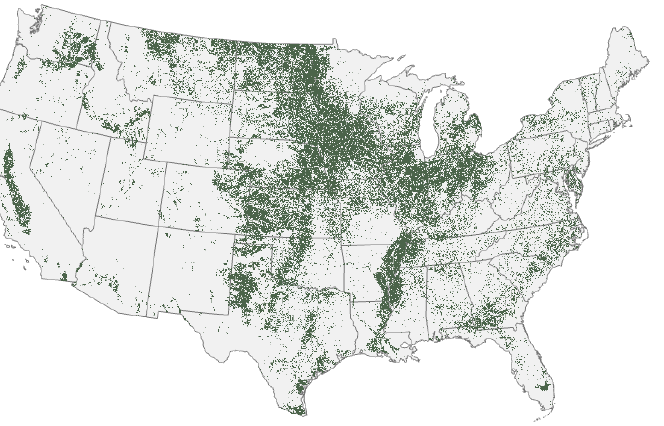
Figure 1. Land use representing cropland in the continental United States based on data from USDA Cropland Data.